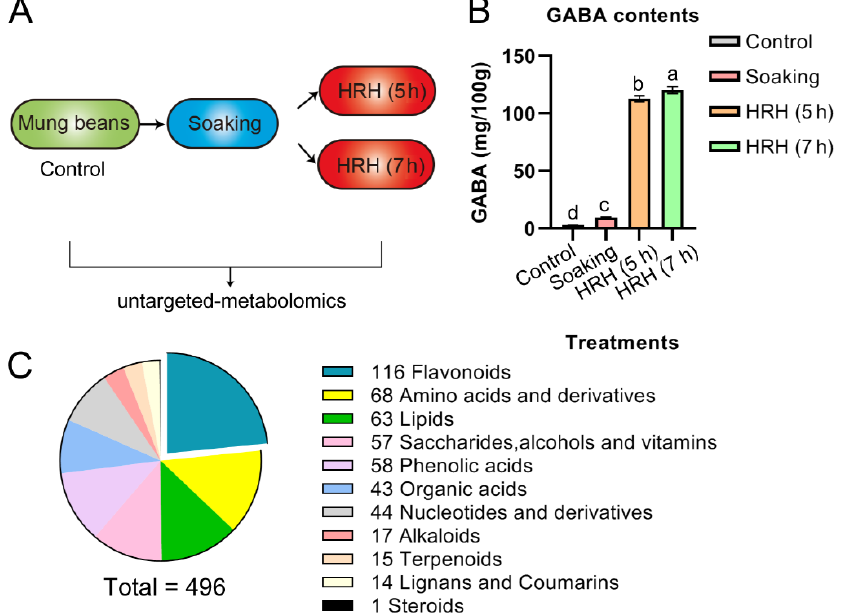
Figure 1. ( A ) Schematics depicting how to prepare the samples in this study. ( B ) GABA content during processing, a,b,c,d, p < 0.05. ( C ) Eleven types of metabolites were identified in mung beans during GABA-enrichment processing.